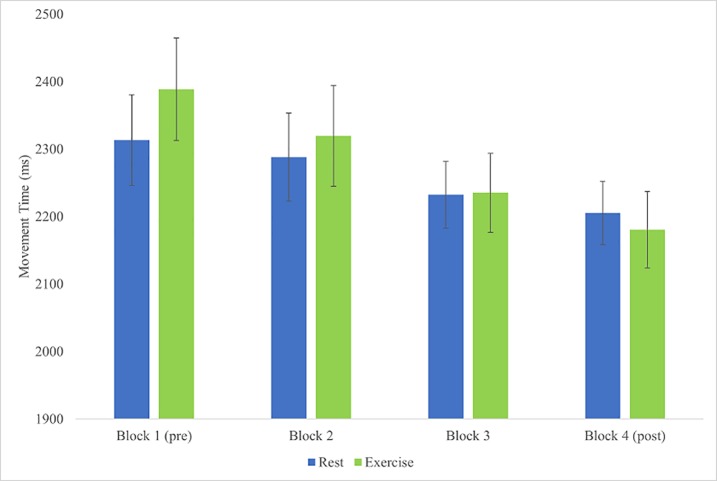
Differences in MT by intervention and block (mean ± SE).